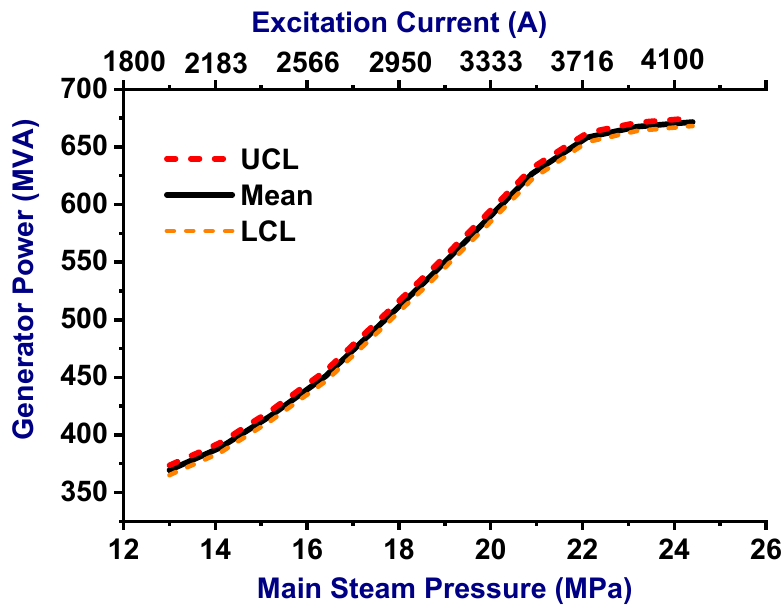
Figure 8. The combined effect of thermo-electric operating parameters on generator power.